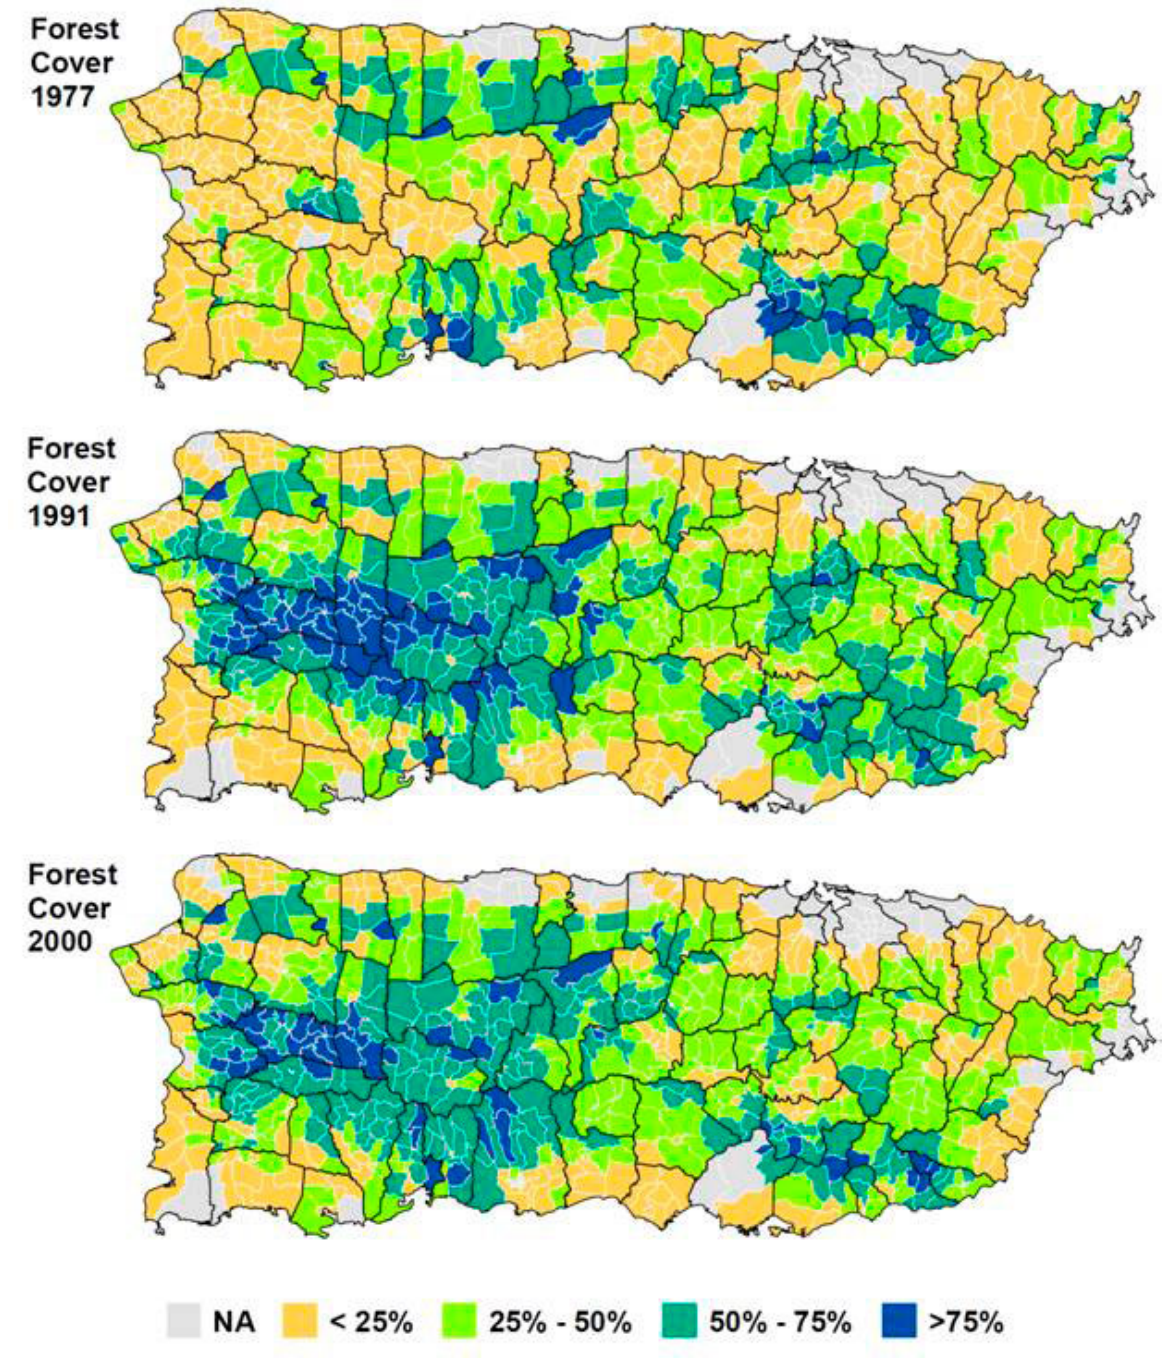
Fig. 1. Percentage forest cover in 1977, 1991, and 2000 land cover/use GIS layer calculated at the barrio (submunicipality) scale. Barrio boundaries are shown in white and municipio boundaries in black (See Appendix for data